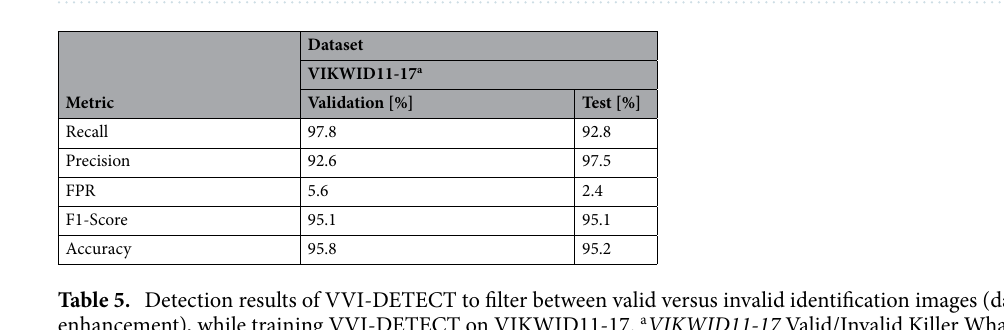
Figure 4. Dorsal fin/saddle patch detection and extraction results based on randomly chosen identification images from various years (2011–2017), applying FIN-DETECT, trained on the machine-extended EADD data archive (see Table 1), and FIN-EXTRACT.